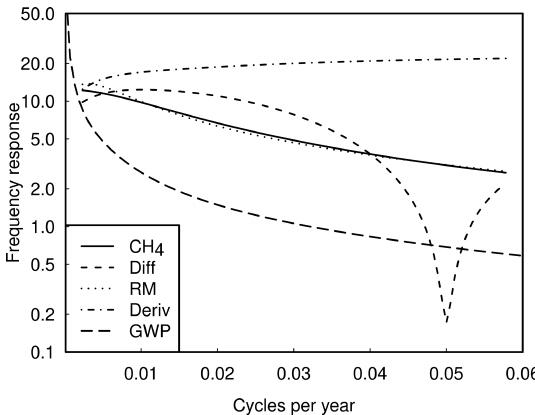
Figure A1. Frequency response for the various cases of ˜ (cid:57)(p) | discussed above, compared to the actual frequency | ˜ R CO 2 (p) (p) | to periodic CH 4 emissions (solid line), using response, | R CH 4 p = 2 πif .